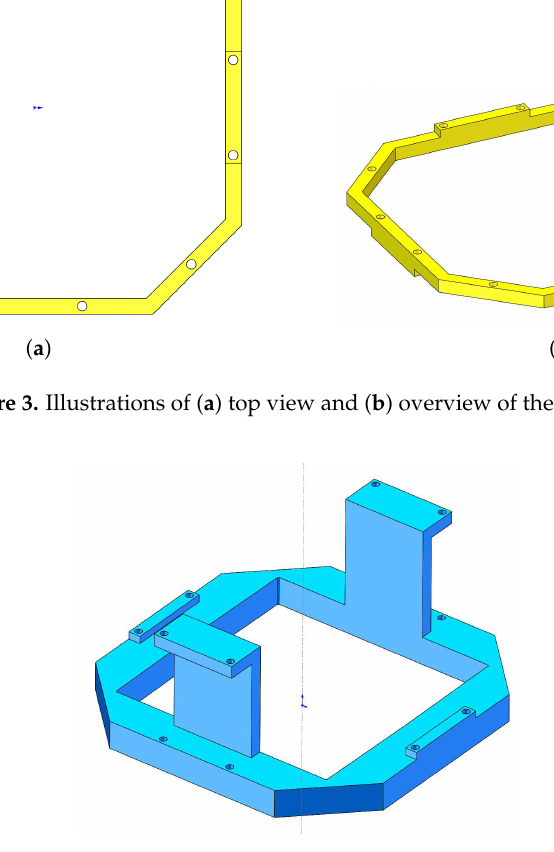
Figure 4. CAD model of the